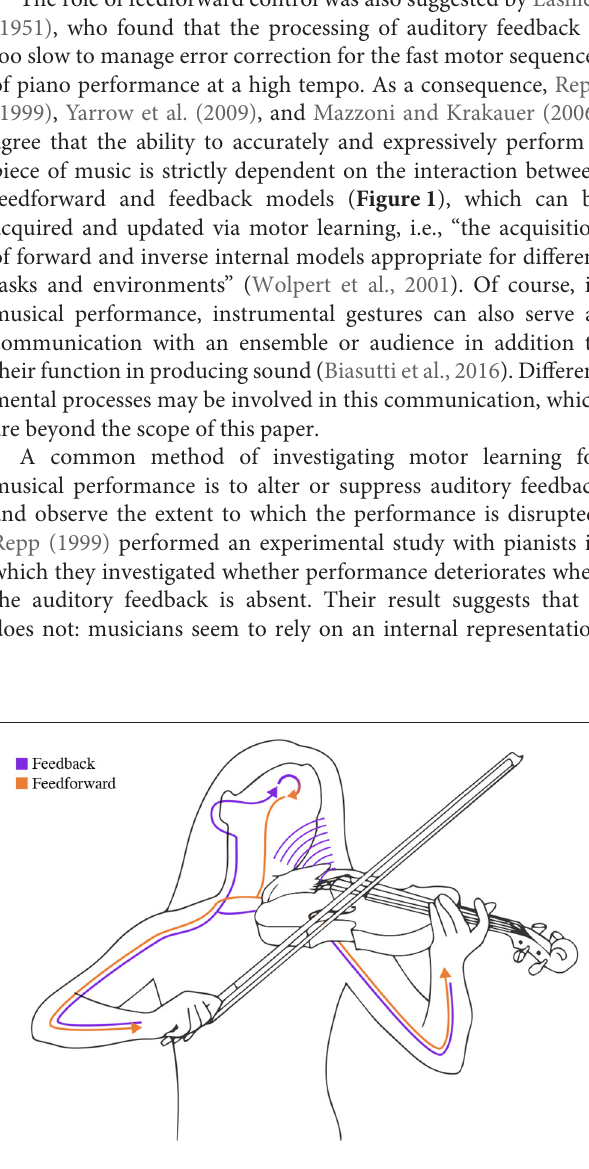
FIGURE 1 | When a musician performs, feedforward and feedback mechanisms interact. The motor system controls the fine movements needed to produce the sound (feedforward). The sound is then processed by the auditory system (feedback), which uses this information to adjust motor